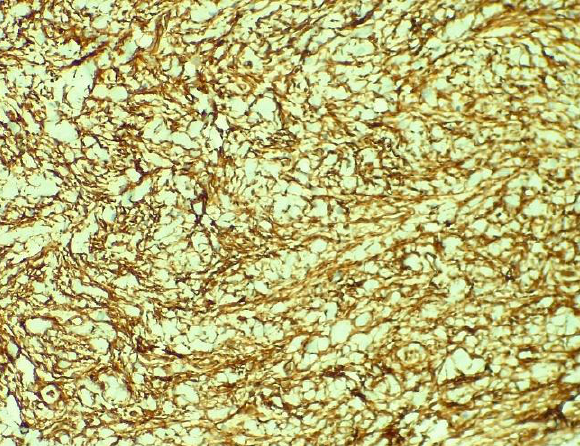
Figure 7. Immunohistochemical examination showing CD34 marker positive in the vessels and the fusiform cells .